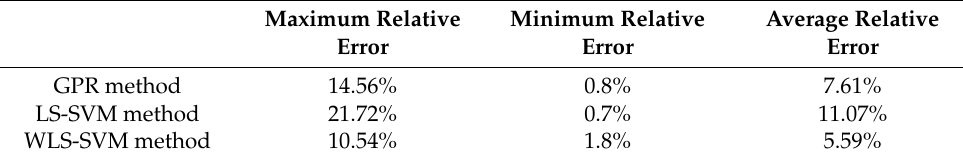
Table 6. Errors between predicted and experimental